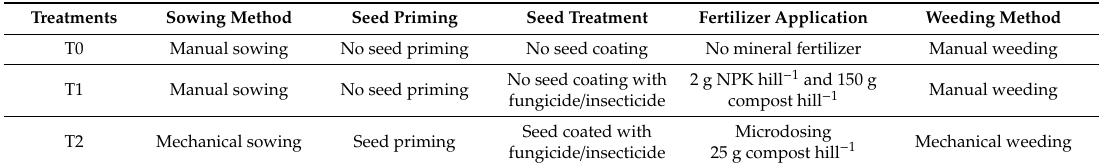
Table 2. Description of the three treatments in the on-farm